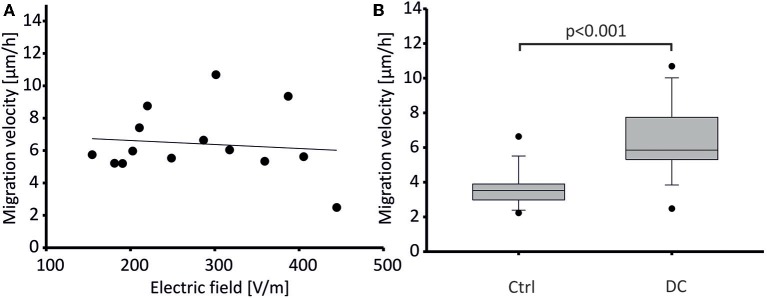
Migration velocity of DC-stimulated human osteoblasts. (A) Migration velocity of osteoblasts did not depend on electric field strength applied. Data points represent mean velocity values from 14 experiments. These were each obtained from n = 21–42 cells. Regression indicated as line. Regression coefficient: −0.0025, n.s. (B) Mean migration velocity (depicted as box plot showing median ± SD, and extreme values as dots) of osteoblasts stimulated by DC fields (DC) was significantly higher than that of unstimulated osteoblasts (Control). Data were obtained from n = 14 paired tissue samples each, p < 0.001.